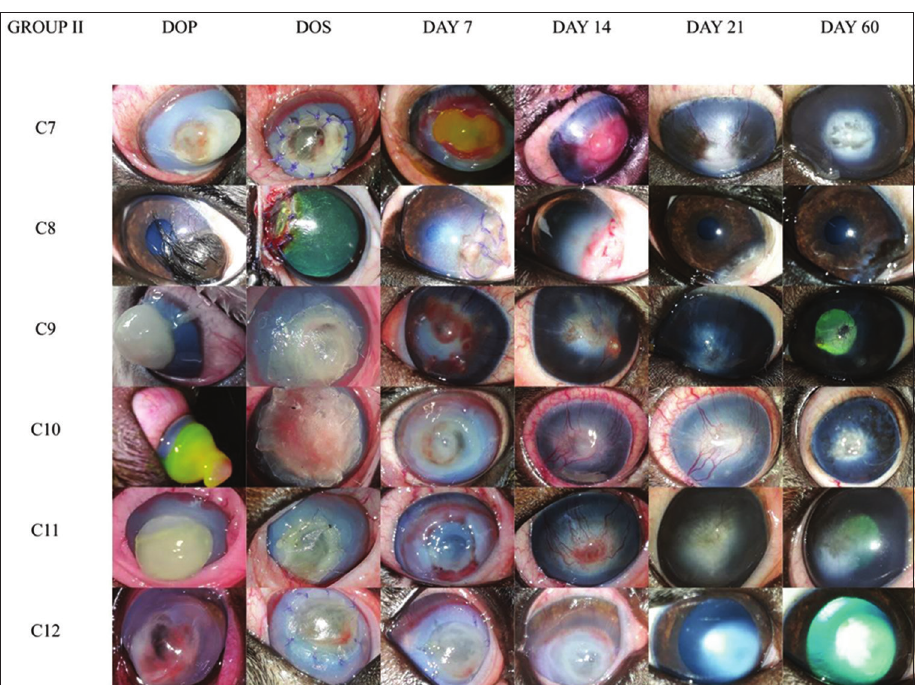
Figure-2: Gross photographs of corneas in Group II on the days of presentation, surgery, and on post-operative days 7, 14, 21, and 60. C7: Full-thickness corneal defect of 10 mm diameter with subsequent iris prolapse, melting edges, diffuse dense corneal edema, and neovascularization from the dorsal limbal border. The cornea remained moderately opaque post- grafting on days 7 and 14 due to intense vascularization and central granulation tissue. It became moderately clear by day 21 with a central scar and pigmentation but regained its clarity by day 60, except at the central region. C8: Congenital unilateral corneal dermoid extending at the temporal limbal border with scleral and corneal attachments, which were surgically removed by superficial keratectomy before grafting. The surgical site became opaque due to granulation and associated corneal edema by days 7 and 14, with scarring by day 21 that resolved by day 60, leaving mild pigmentation. C9: Staphyloma of 9 mm diameter with protruding endothelial layer stained positive with fluorescein dye. The entire cornea was edematous, and vascularization of the cornea was evident from almost all quadrants. Postoperatively, the cornea remained moderately opaque on days 7 and 14 due to intense vascularization, but regained clarity by day 21 which improved greatly by day 60, except for the central ghost vessel. C10: Twelve millimeter diameter full-thickness corneal defect with exposed endothelium and iris prolapse (1 cm above the corneal surface) staining positive with FDT. Corneal edema persisted up to day 7. Neovascularization was at its peak on day 14 and persisted through day 21 but resolved completely, leaving a central corneal scar, and mild melanosis compared to the initial defect size. C11: Staphyloma of 9 mm diameter with positive FDT, diffuse corneal edema, and pannus progression from the superior limbal border. Corneal edema persisted until day 7. The cornea was profusely neovascularized on day 14, eventually leaving a clear cornea except for the haze scar. C12: Chronic keratomalacia with a 10 mm diameter defect staining positive FDT, diffuse corneal edema, and